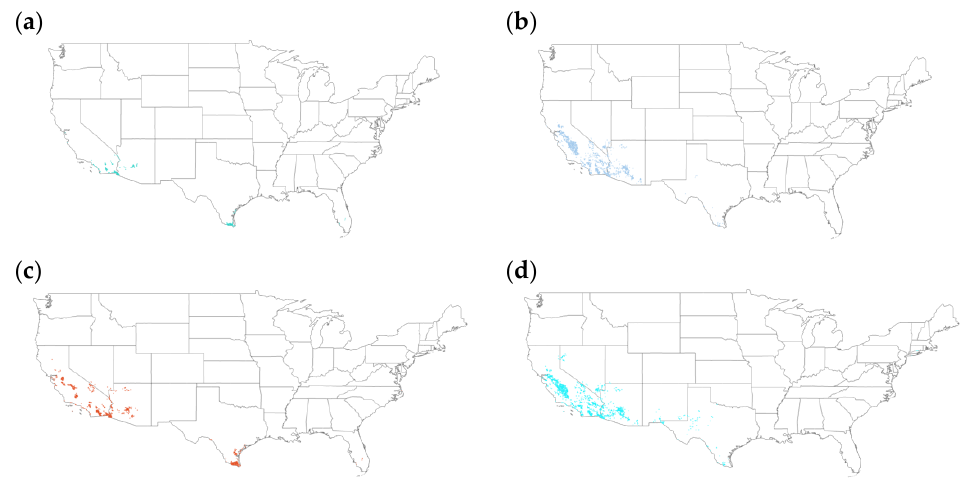
Figure 8. Combination of precipitation (25 mm threshold) and temperature (32 °F and 28 °F) for November and December within cropland areas (note: 32 °F = 0 °C, 28 °F = −2 .2 °C). ( a ) 25 mm rainfall and 32 °F in December ( b ) 25 mm rainfall 32 °F in November ( c ) 25 mm rainfall and 28 °F in December ( d ) 25 mm rainfall and 28 °F in November.